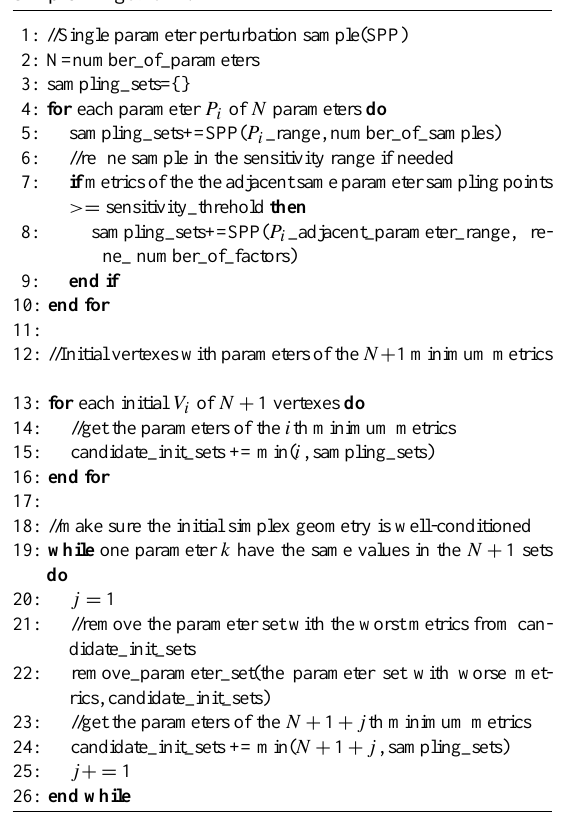
Algorithm 1 Preprocessing the initial values of Downhill Simplex